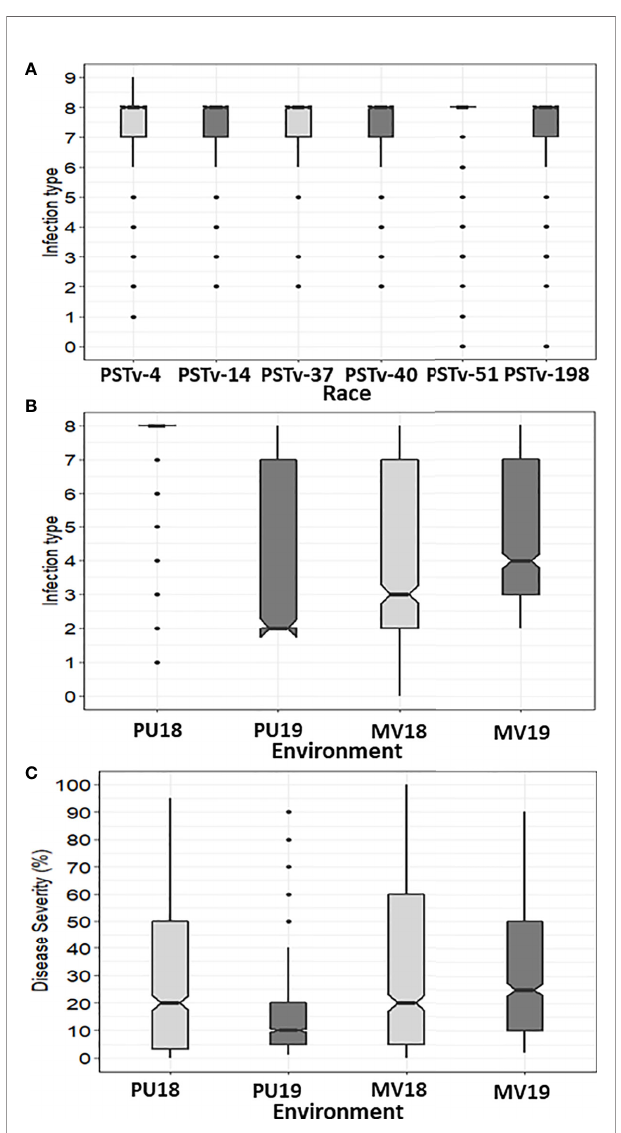
FIGURE 1 | Distributions of stripe rust infection type (IT) and disease severity (DS). (A) IT distributions in the seedling tests with different races of Puccinia striiformis f. sp. tritici . (B) IT distribution across fi eld environments including Pullman 2018 (Pu18), Mount Vernon 2018 (MV18), Pullman 2019 (Pu19), and Mount Vernon 2019 (MV19). (C) DS distribution across fi eld environments. Solid horizontal lines display the median values. Notches display a 95% con fi dence interval around the median. Top and bottom box edges display the fi rst and third quartile values, respectively. Whiskers display the largest and smallest values within 1.5 times the interquartile range. Dots represent the values out of 1.5 times the interquartile range.